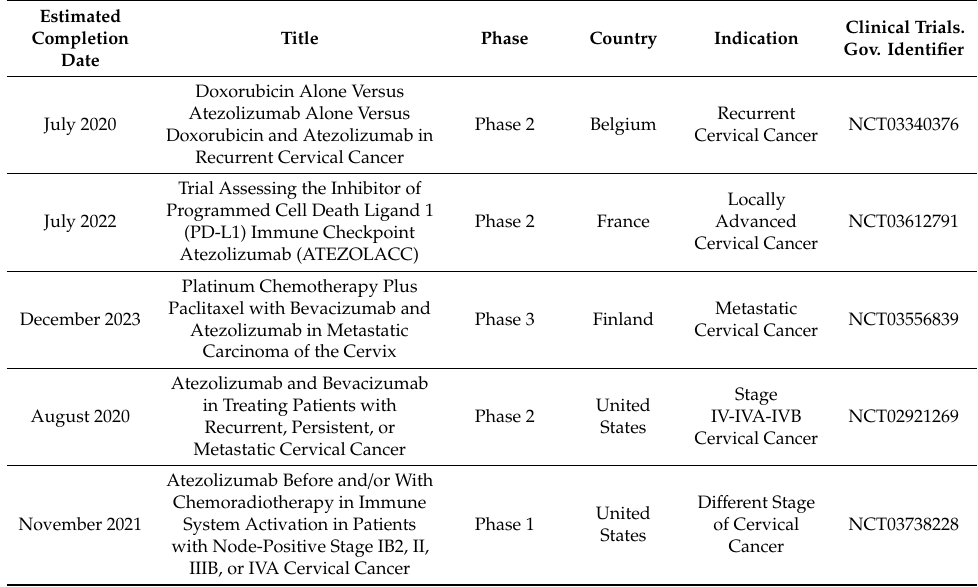
Table 2. Ongoing trials (up to February 2020) of atezolizumab alone or in combination with chemotherapy in cervical